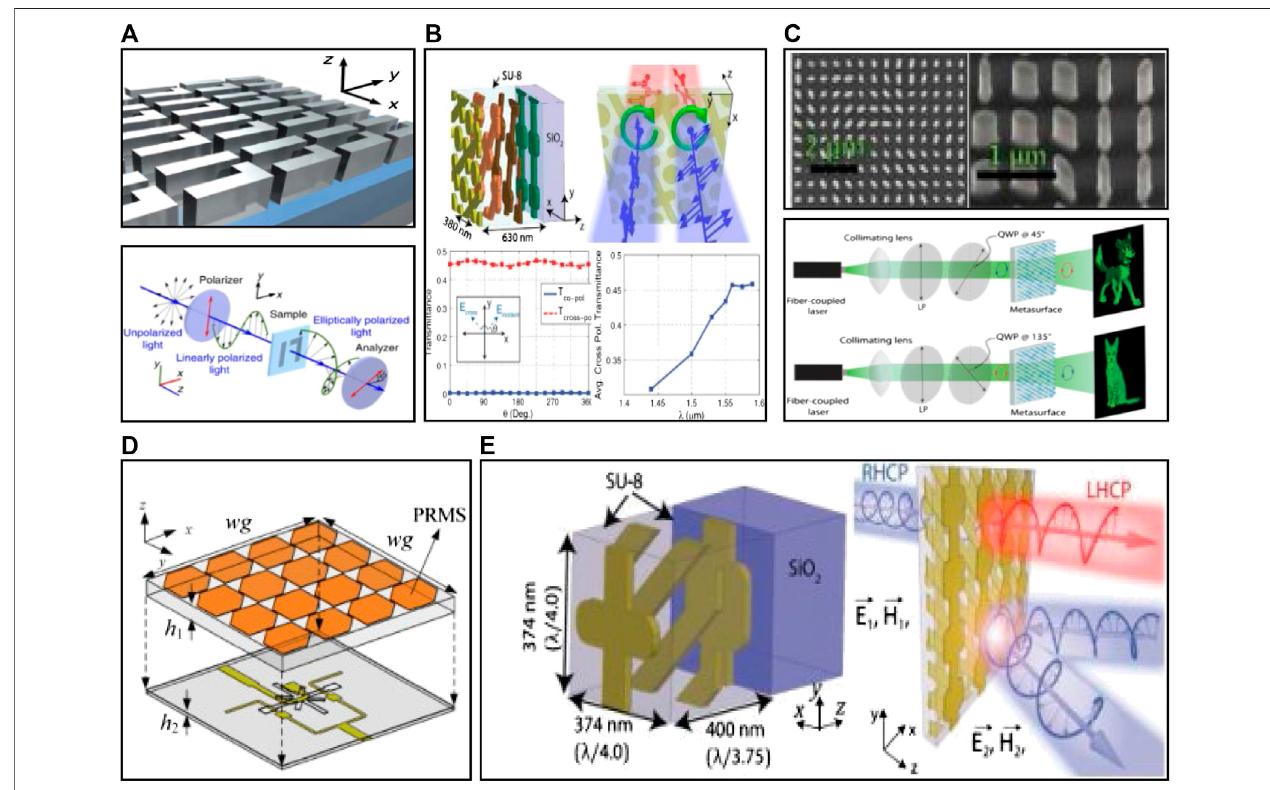
FIGURE 3 | Polarization-modulated metasurface design and its typical applications. (A) All-dielectric metasurface [85], (B) , (E) multilayer metasurface [86, 87], (C) holographic metasurfaces that depend on polarization [88], and (D) topology of metasurface antenna [90].